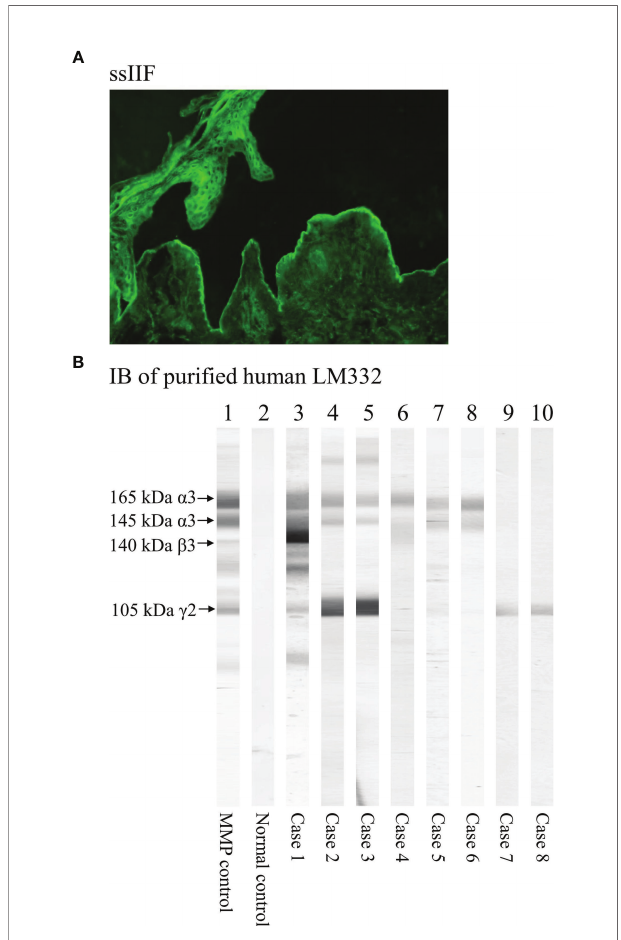
FIGURE 1 | The representative fi gures of serological methods to detect autoantibodies in LM332-MMP. (A) Immuno fl uorescence using 1M-NaCl-split human skin (ssIIF) showing IgG reactivity with dermal side of the split by a LM332-MMP serum. (B) The results of immunoblotting (IB) of puri fi ed human LM332. The positive control serum (lane 1) and eight LM332-MMP sera (lanes 3 – 10 for cases 1 – 8) reacted with the three subunits of laminin-332 with various patterns, while normal control serum (lane 2) showed negative reactivity. Speci fi cally, positive control and case 1 reacted with all the three subunits, 165 kDa and 145 kDa LM a 3, 140 kDa LM b 3, and 105 kDa LM g 2 of LM332; cases 2, 3, 5, and 6 reacted with both LM a 3 and LM g 2; case 4 reacted only with LM a 3; and cases 7 and 8 reacted only with LM g